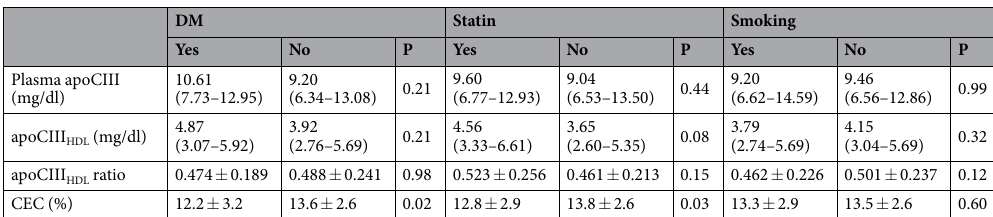
Table 2. Comparison of apoCIII concentration and HDL-mediated cholesterol efflux capacity between different groups. DM indicates diabetes mellitus; apoCIII, apolipoprotein C-III; apoCIII HDL , apolipoprotein CIII in apoB-depleted plasma; CEC, cholesterol efflux capacity.